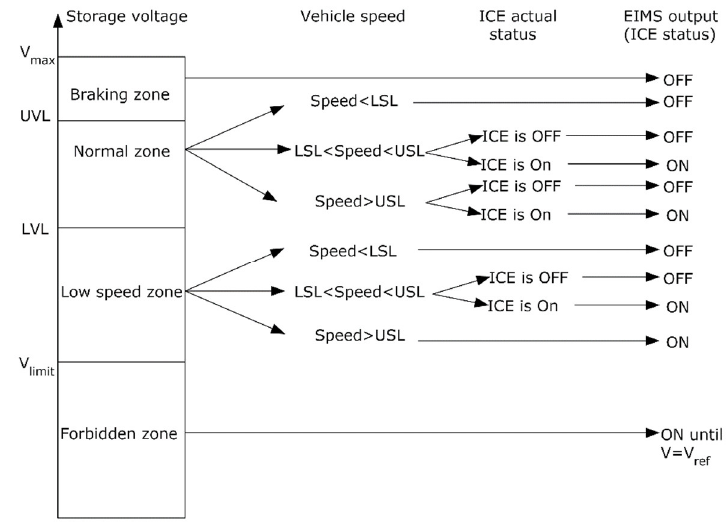
Figure 23. four operating areas in the EIMS regulation. Figure 23. Four operating areas in the EIMS regulation.